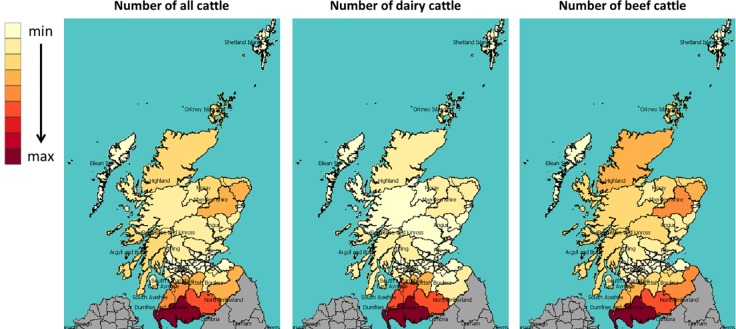
The number of all, beef and dairy cattle in each constituency in 2000.